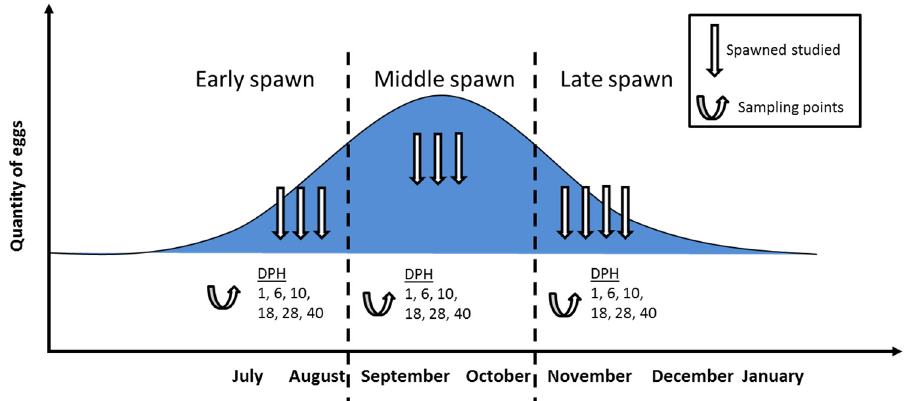
Figure 1. Sampling scheme of Seriola lalandi larvae from three different spawning phases (early, middle, and late spawn) during the spawning season. Fa tt y acid pro fi le: 1-6-10-18-28-40 dph. Malformation rate: 18 and 28 dph. Trascriptomic analysis: 40 dph.